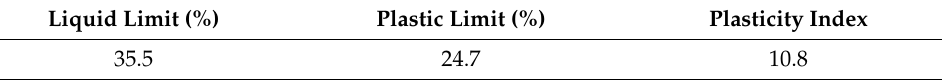
Table 2. Physical properties parameters of silica